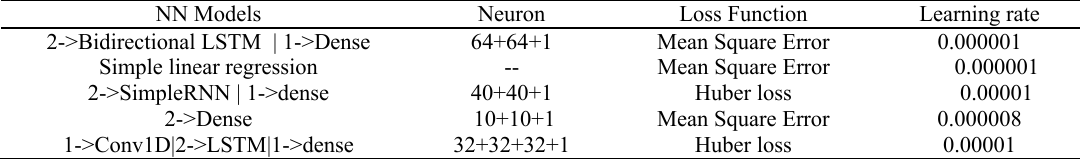
Table 3. Performance evaluation measures for different models on Chennai station